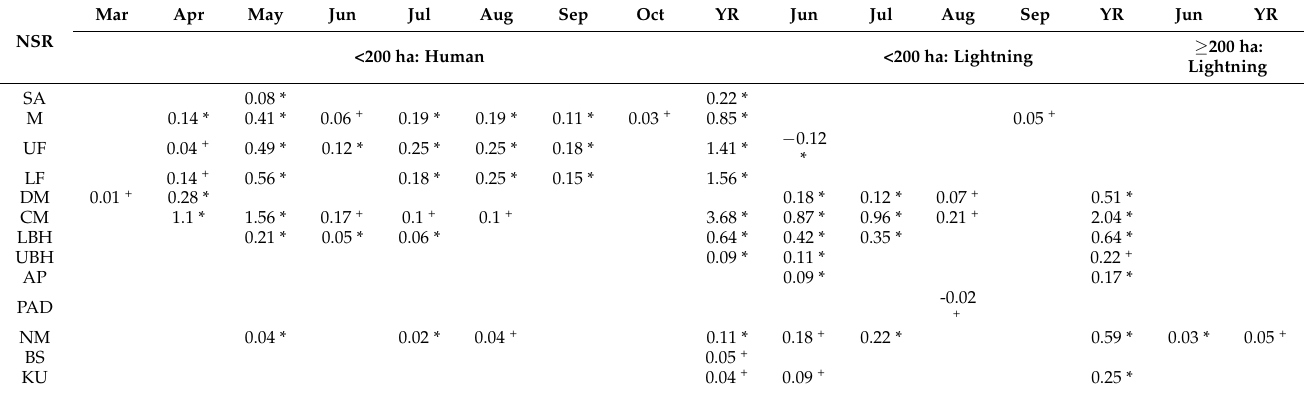
Table 3. Significant trends of the number of monthly and annual (YR) fire occurrences during 1959– 2021 in the natural subregions of Alberta. Slopes (NOF/year) at the significance levels of 99% (*) and 95% ( + ) are presented for large and small fires caused by human and